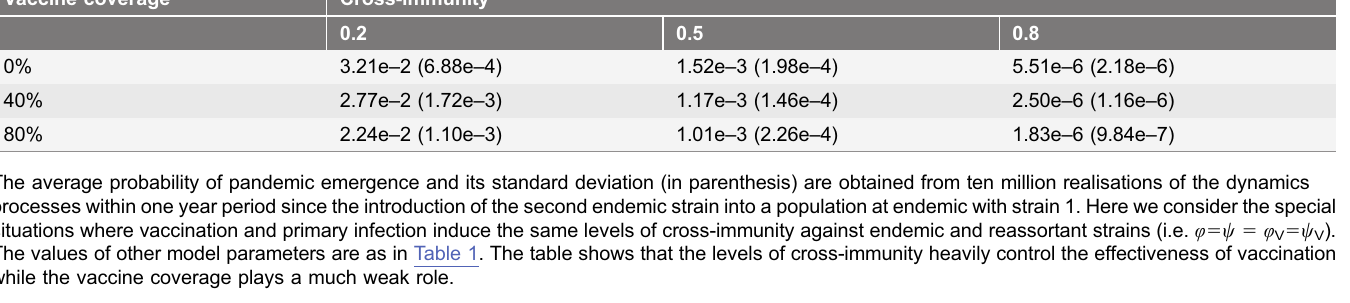
Table 3. Impact of vaccination on the emergence probability of pandemic strains via reassortment. Vaccine coverage